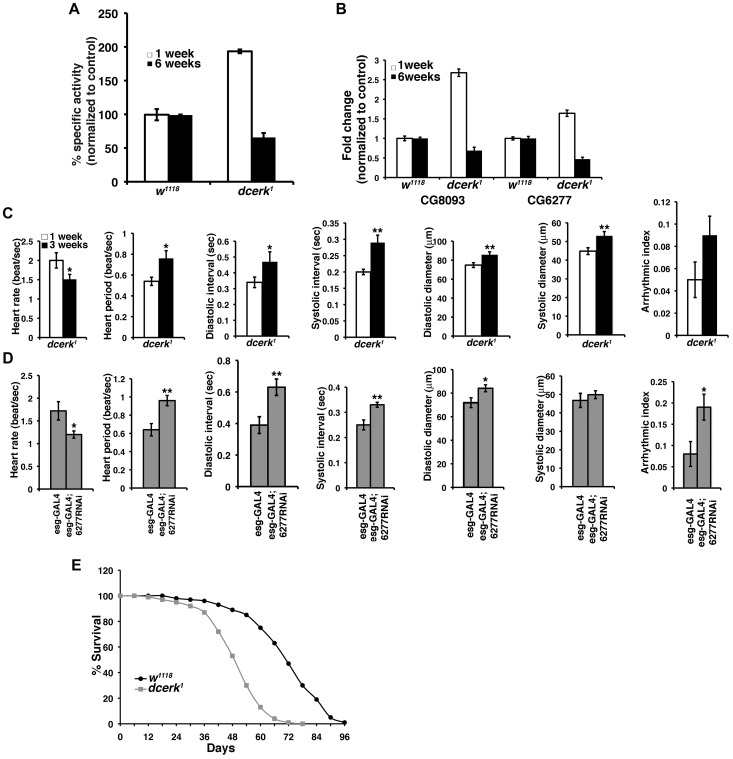
Failure of adaptive mechanisms leads to cardiac dysfunction and reduction in adult life span of dcerk1.(A). Measurement of Pglym enzyme activity in young (1 week) and aged (6 weeks) w1118 and dcerk1 flies shows a significant decrease in activity in older dcerk1. (B). Comparison of transcript levels of CG8093 and CG6277 by QPCR in 1week and 6 week old flies, reveals decrease in their transcripts in aged dcerk1 flies. (C). Comparison of several cardiac performance indices in 1 and 3 week old esgGAL4 dcerk1 flies reveals progressive decline in heart function with decreased heart rate, increased heart period and dilated heart chamber. n = 15, bar represents standard error of mean and statistical significance was determined using Student's t test; * denotes P< = 0.05-0.01, ** is P< = 0.01-0.001 is and *** denotes P< = 0.001-0.0001. (D). Knockdown of CG6277 in 3 week old wild type flies also shows decreased heart rate, increased heart period, dilated heart chamber and arrhythmia. n = 10, bar represents standard error of mean and statistical significance was determined using Student's t test; * denotes P< = 0.05-0.01, ** is P< = 0.01-0.001 is and *** denotes P< = 0.001-0.0001. (E). dcerk1 have reduced adult life span compared to w1118 flies. The survivorship curve of dcerk1 and w1118 represents data from 600 flies in duplicate.